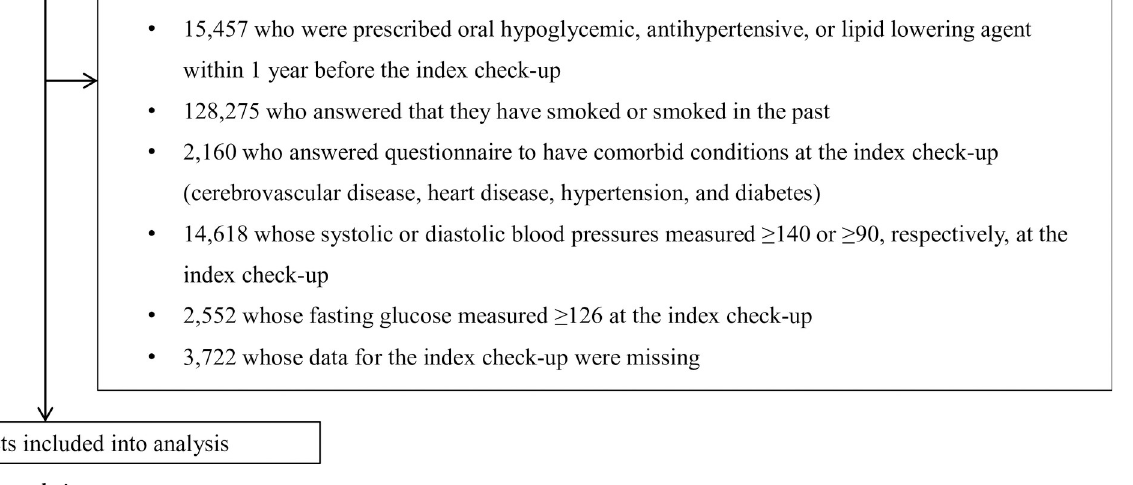
Fig 1. Overview of the study population. https://doi.org/10.1371/journal.pone.0262715.g001 Table 1. Baseline characteristics of study